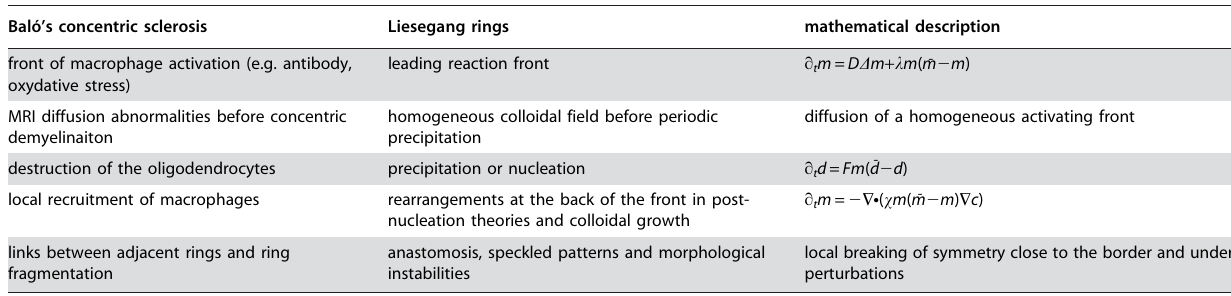
Table 1. Analogies between Balo´’s sclerosis, Liesegang rings and the chemotactic description (model (3)-(4)-(5)). .. ... .... ... ... .... ... ... .... ... ... .... ... ... .... ... ... .... ... ... .... ... ... .... ... ... .... ... ... .... ... ... .... ... ... .... ... ... .... ... ... .... ... ... . Balo´’s concentric sclerosis Liesegang rings